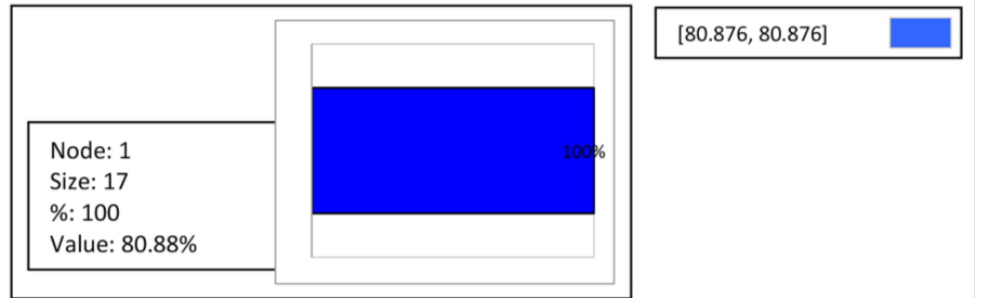
Figure 5. Regression tree: decision making for TSS .